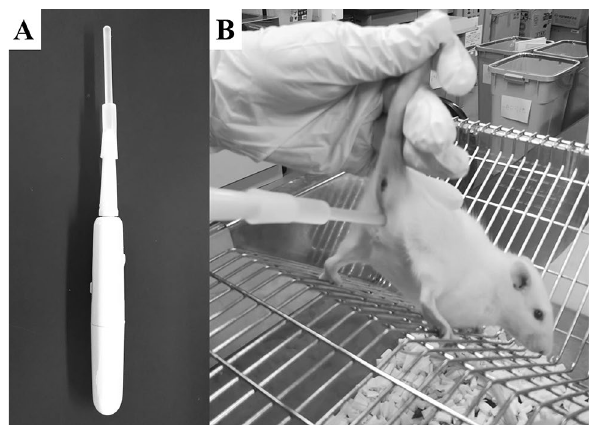
Figure 1. Sonic vibrator ( A ). Probe were inserted in the vagina of female ( B